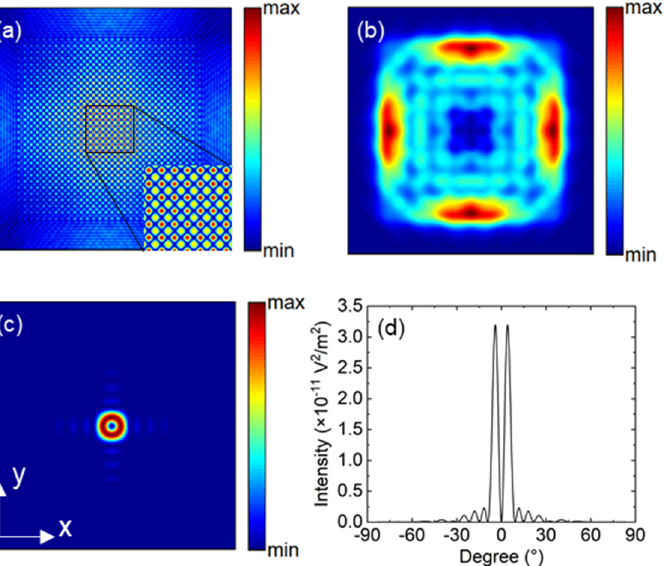
Figure 2. The simulation results of the square-lattice PCSEL with circular air holes. ( a ) Magnetic field distribution inside the PhC layer. ( b ) Near-field pattern (NFP) and ( c ) far-field pattern (FFP) of the PCSEL. ( d ) The intensity profile at the center of ( c ) along x-direction.